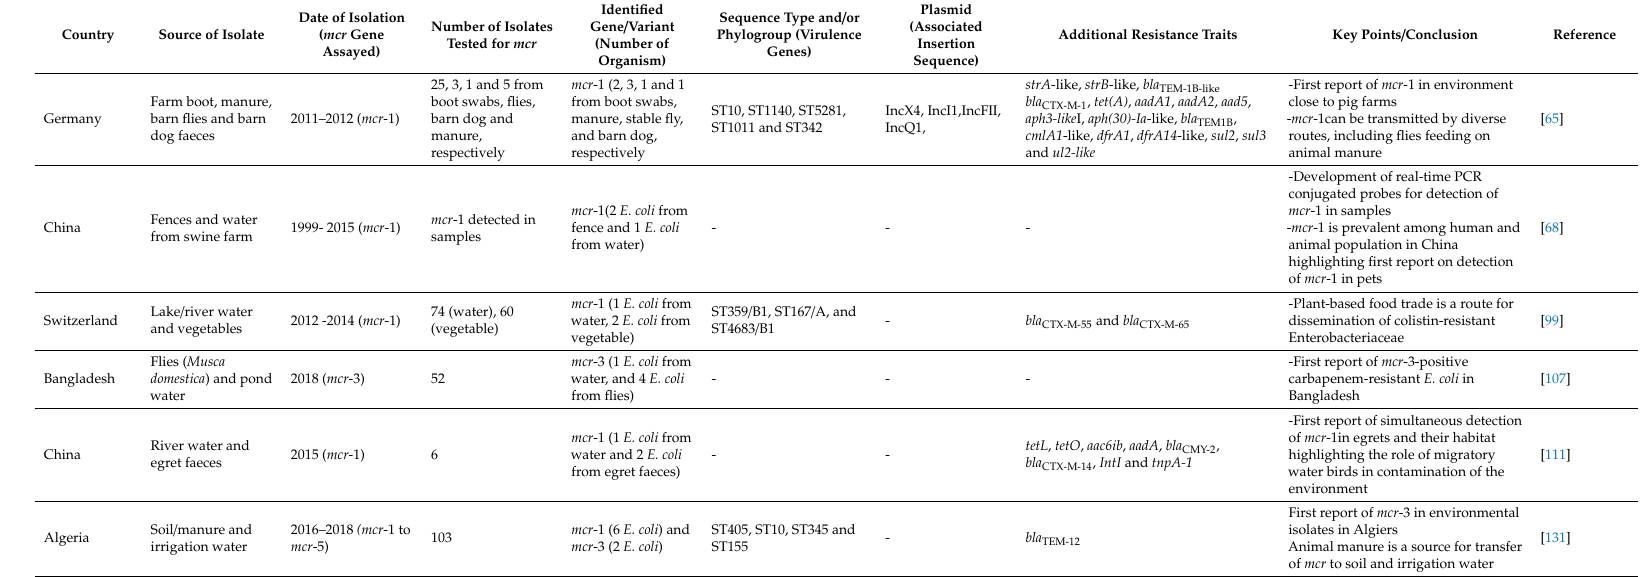
Table 8. Studies reporting plasmid-mediated colistin resistance in isolates from multiple environmental